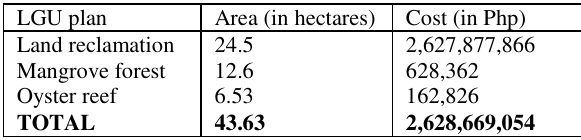
Table 1 . Estimated figures for implementing the LGU plan.